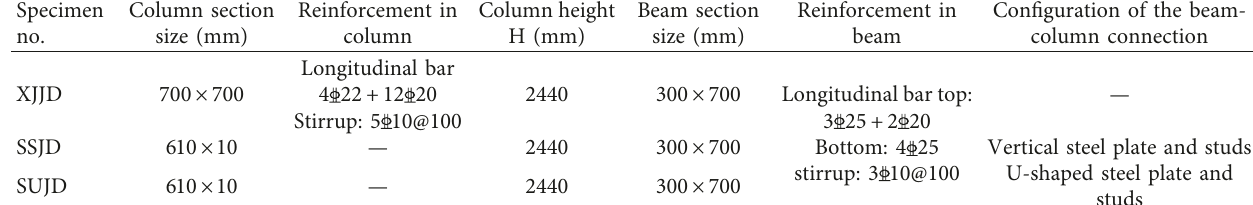
Table 1: Parameters of